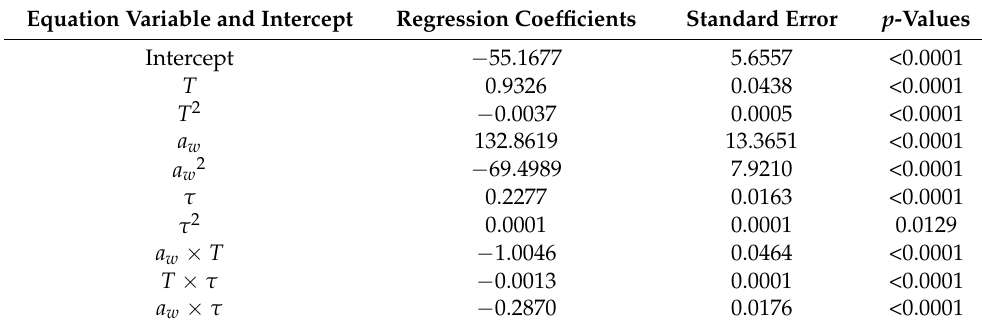
Table 2. Results of the response surface regression: regression coefficients, standard errors and probability levels for the developed regression model.